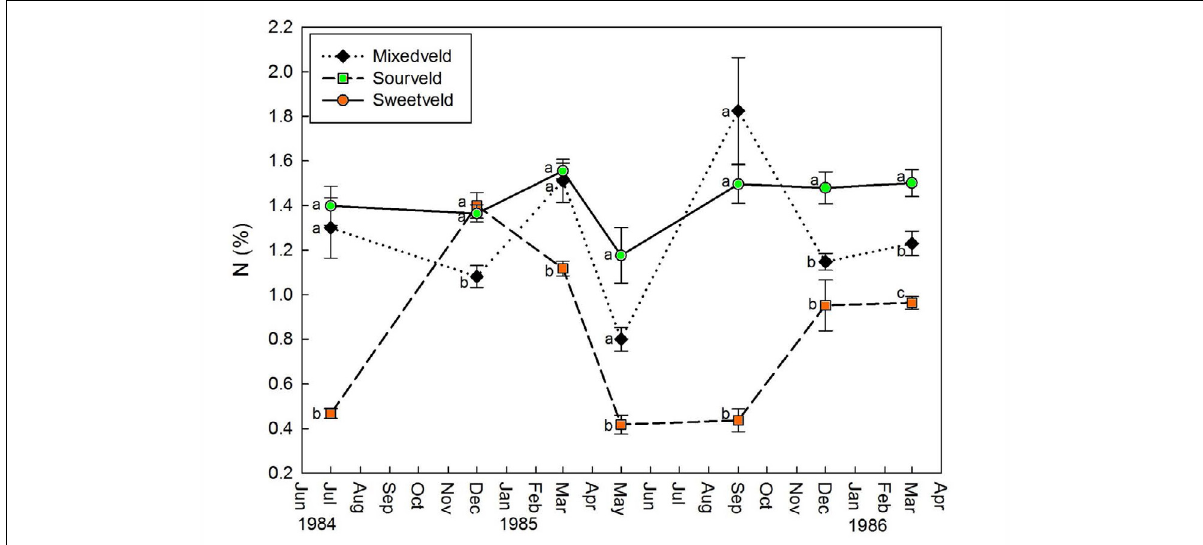
Figure 3: Seasonal trends in mean (±s.e.) leaf nitrogen concentration (%) measured in three grassland types in KwaZulu-Natal. Means within sampling dates with letters in common were not different ( p =